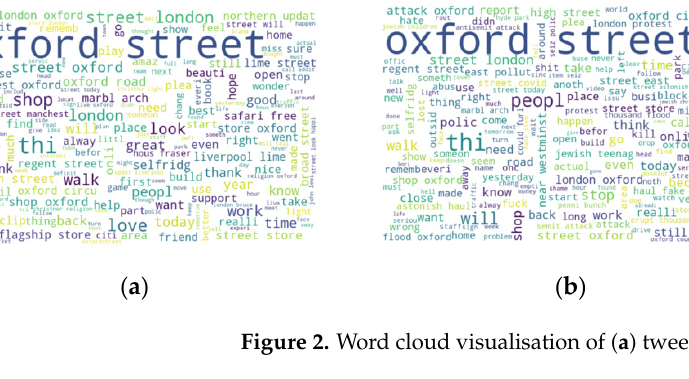
Table 2. Most frequently used words in tweets with positive, negative, or neutral sentiment. Word